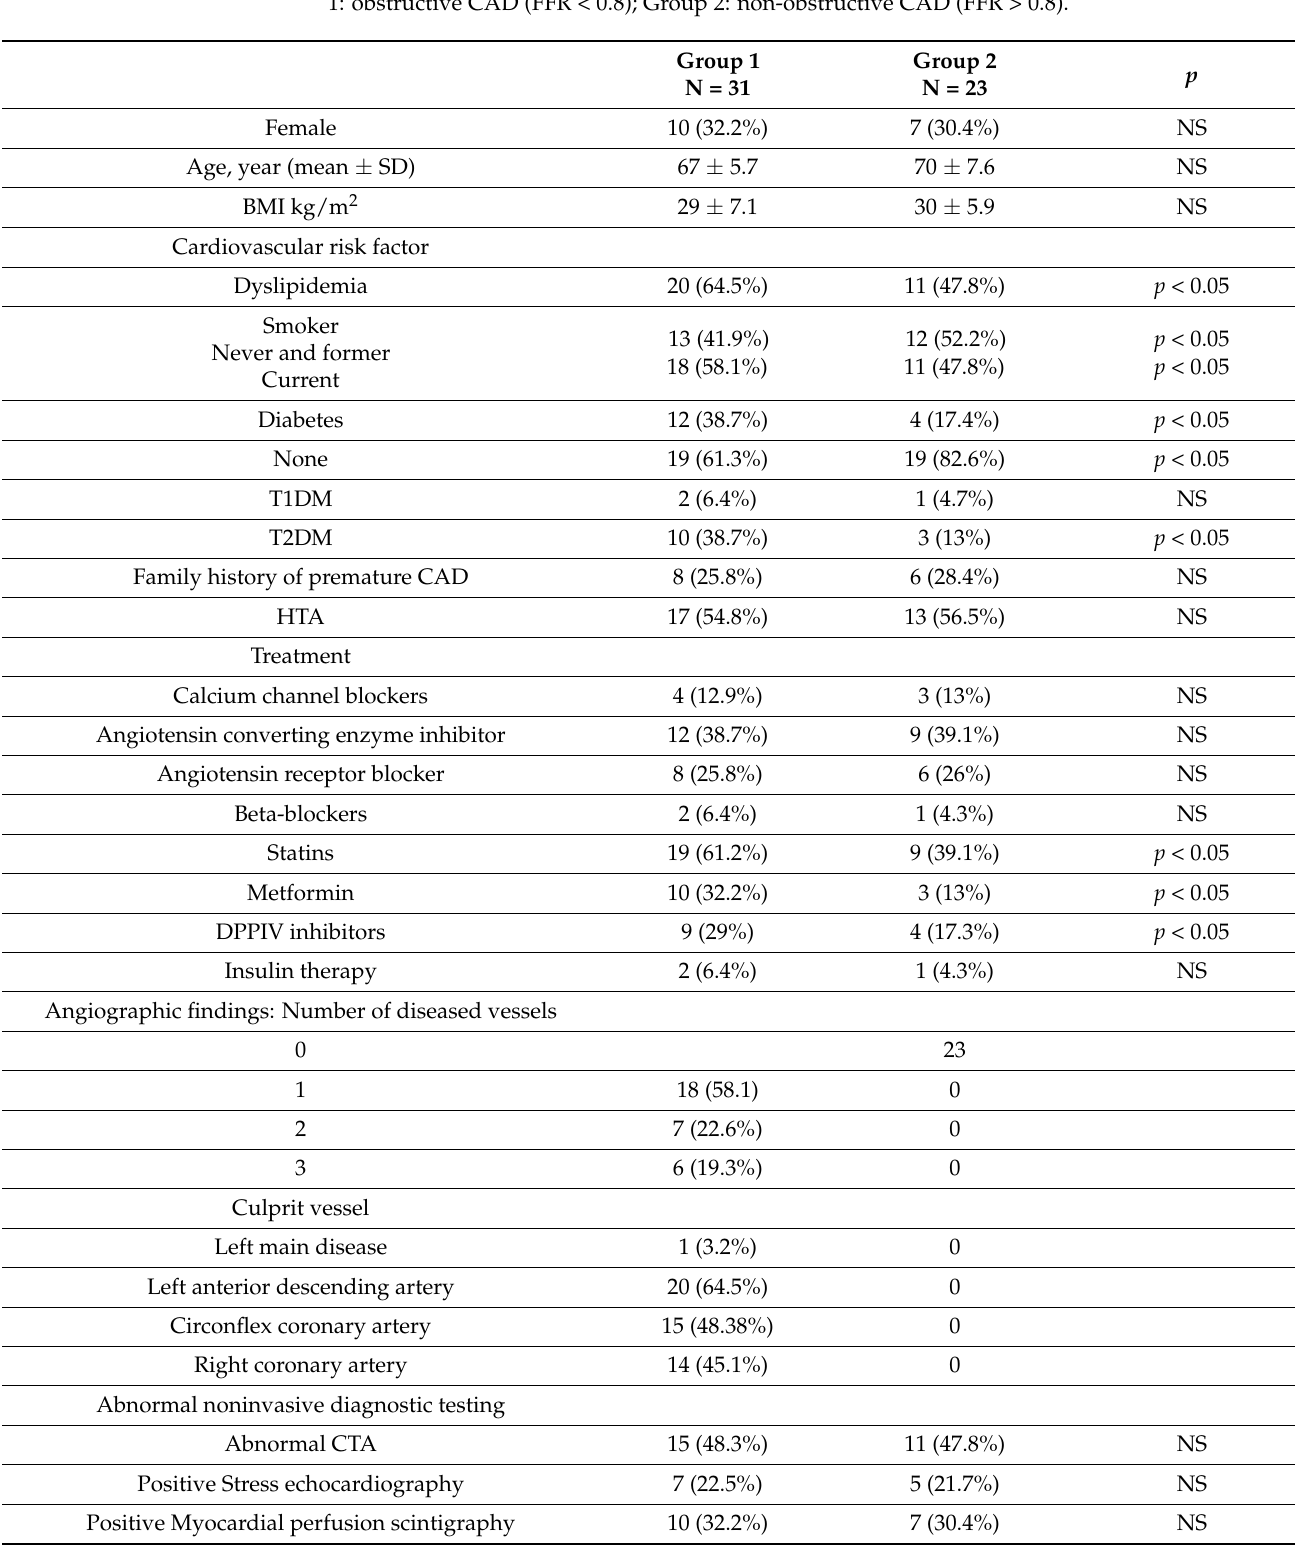
Table 1. Demographics, risk factors, angiographic data, and positive non-invasive diagnostic